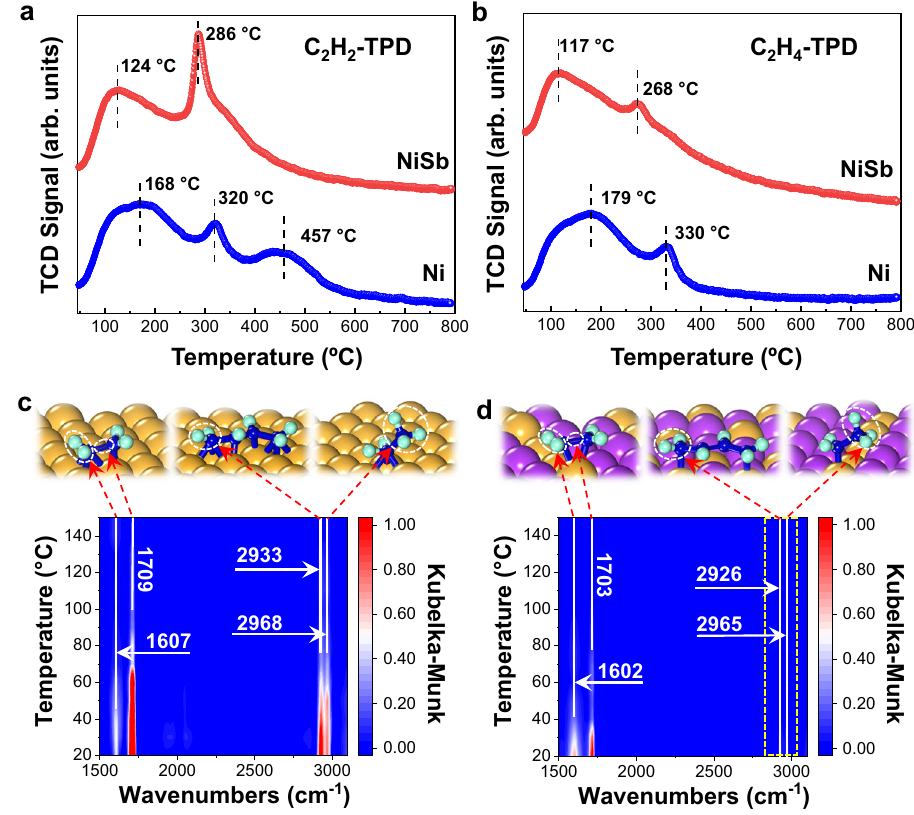
Fig. 7| Adsorption/desorptionandhydrogenationbehaviorsonNi 1 Sb 2 . a C 2 H 2 - TPD and b C 2 H 4 -TPD pro fi les of the Niand NiSbcatalysts.In-situ DRIFTSspectraof the hydrogenation of pre-adsorbed acetylene on c Ni and d NiSb catalysts at